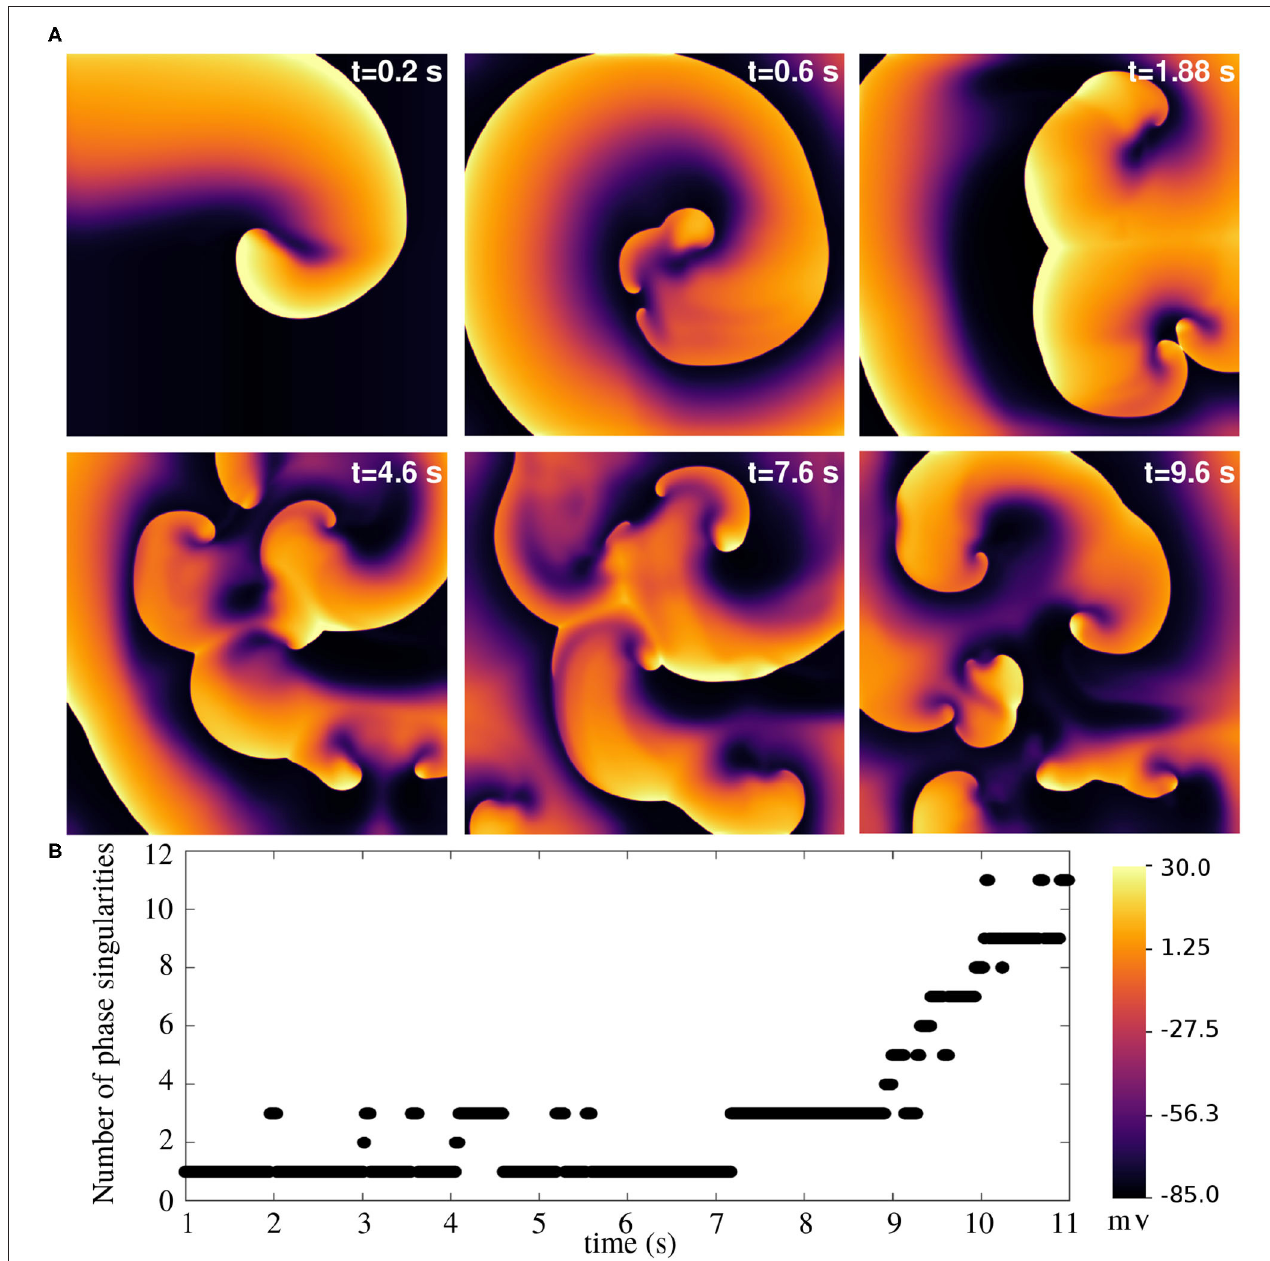
FIGURE 13 | Spiral wave breakup in a 2D pig atrial tissue of size 11.26 × 11.26 cm 2 with G Kr , max reduced to 0.25x its value in the healthy pig model. (A) Pseudocolour plots of the membrane voltage distribution at different times demonstrates the occurrence of multiple spiral waves in the domain. (B) Quantification of number of spiral waves in the domain at various times, measured as the number of phase singularities (one located at each spiral